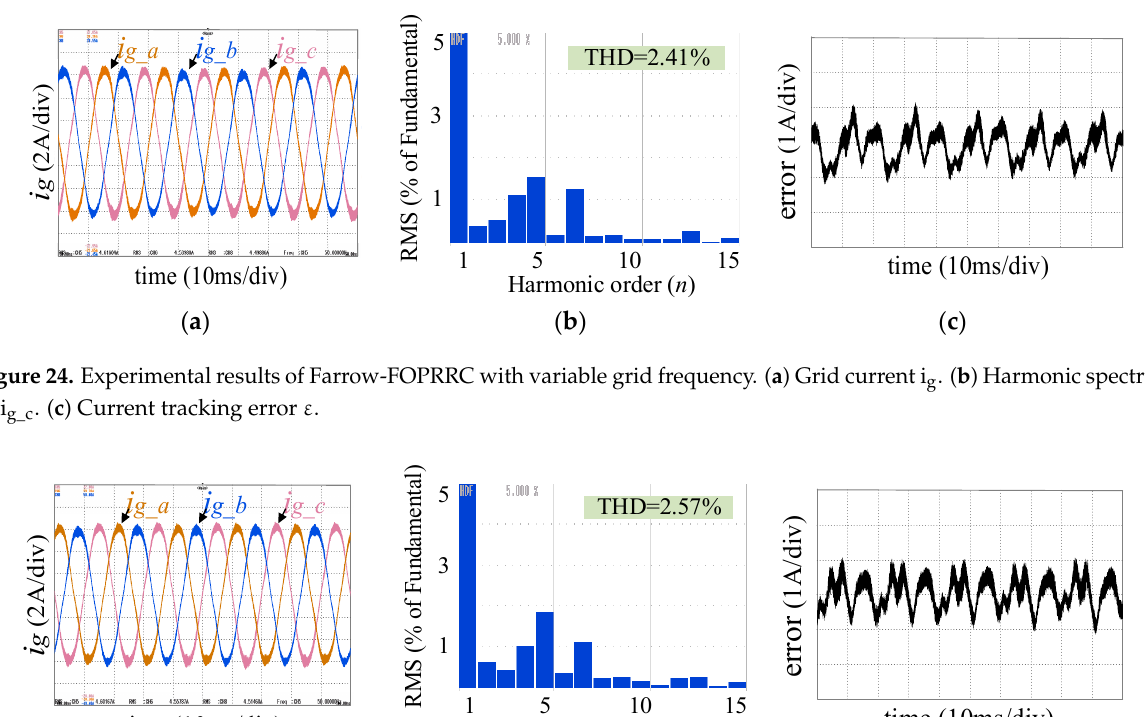
Figure 23. Experimental results of CPRRC with variable grid frequency. ( a ) Grid current i g . ( b ) Harmonic spectrum of i g_c . ( c ) Current tracking error ɛ .